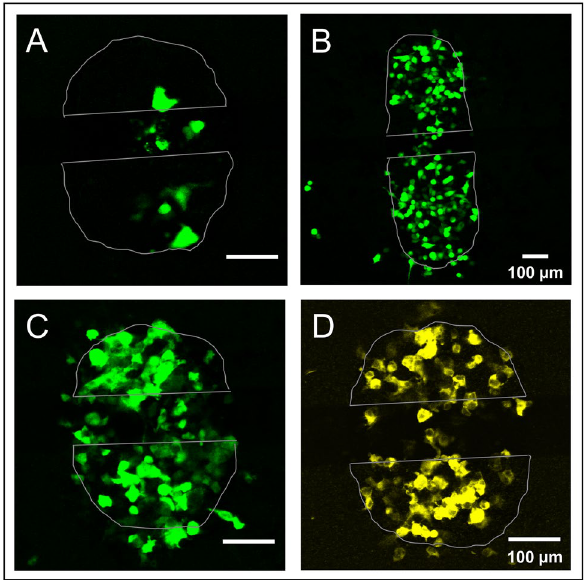
Figure 6. Electrotransfection of adherent mammalian cells with DNA expression plasmids. ( A – D ) Confocal fluorescence micrographs of adherent cells 24 h after electroporation in the presence of plasmid DNA encoding ( A – C ) EGFP ( A : NRK; B : Hep-G2; C : HEK 293) or ( D ) EYFP-actin (HEK 293) The position of the electrodes are marked by grey outlines. In ( B ) a variant of small volume arrays with larger electrode areas (10 −3 cm 2 ) was used. Electroporation was performed with 200 ms electrical pulses of 5.0 V amplitude at an AC frequency of 40